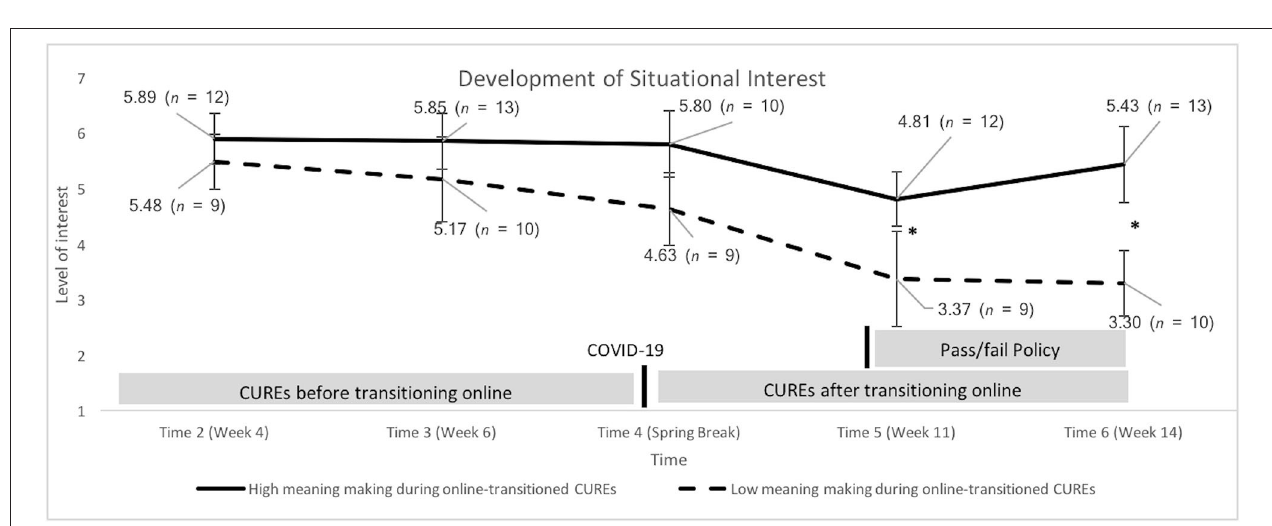
FIGURE 2 | Students’ situational interest as a function of students’ meaning making during online-transitioned CUREs. Covariates appearing in the model are evaluated at the following values: meaning making in the course = 3.86, individual interest = 5.37. Error bars represent 95% confidence intervals. High meaning making group: students who self-reported “always” or “most of the time” seeing the connections between learning and their academic or professional goals during the online course. Low meaning making group: students who self-reported “never” or “sometimes” seeing the connections between learning and their academic or professional goals during the online